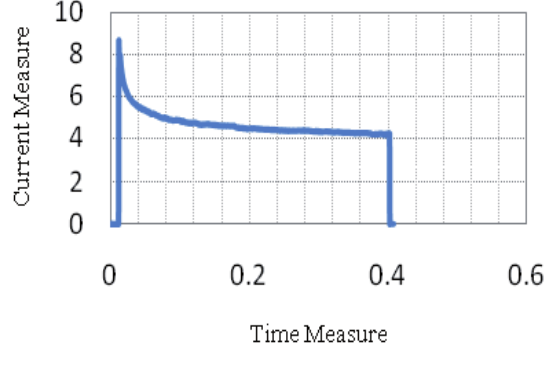
Figure 4. Typical response curve for SPC measurements.